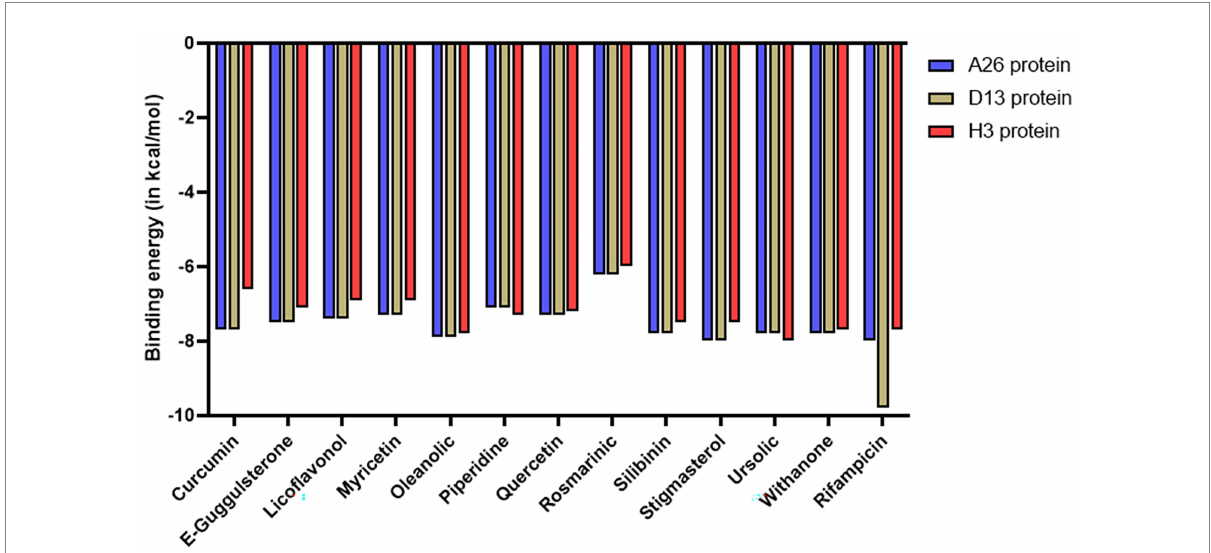
FIGURE 2 Bar graph depicting the binding energies of different phytochemicals docked against D13, A26, and H3 envelope proteins of MPXV. Rifampicin was used as a